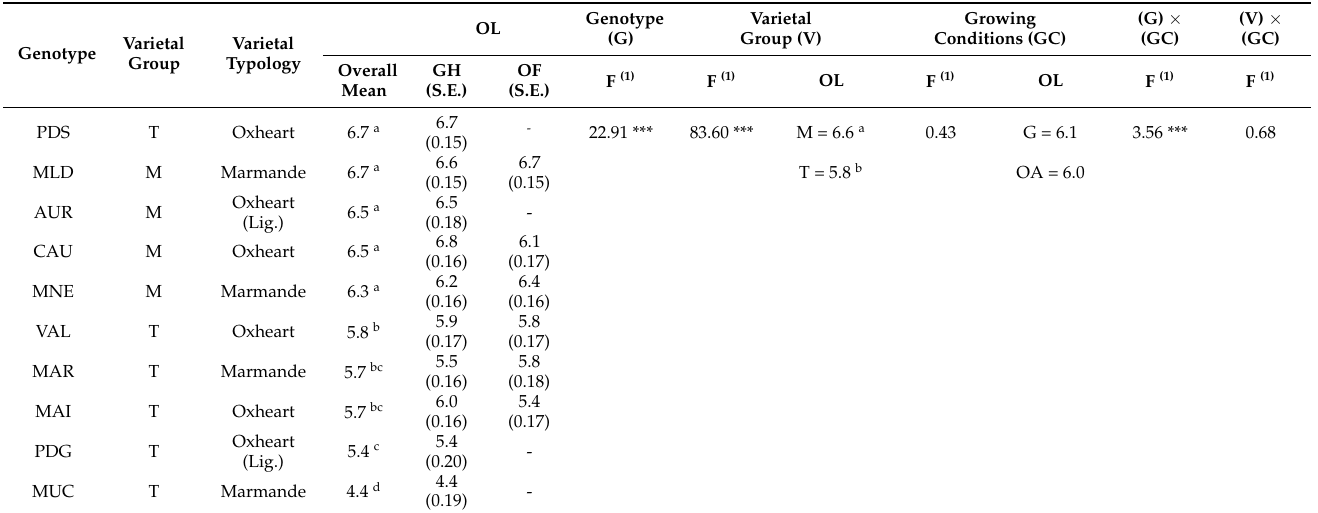
Table 4. Analysis of variance and mean overall liking scores ( n = 123) of tomato samples harvested at the red ripe stage in Spain (10-point hedonic